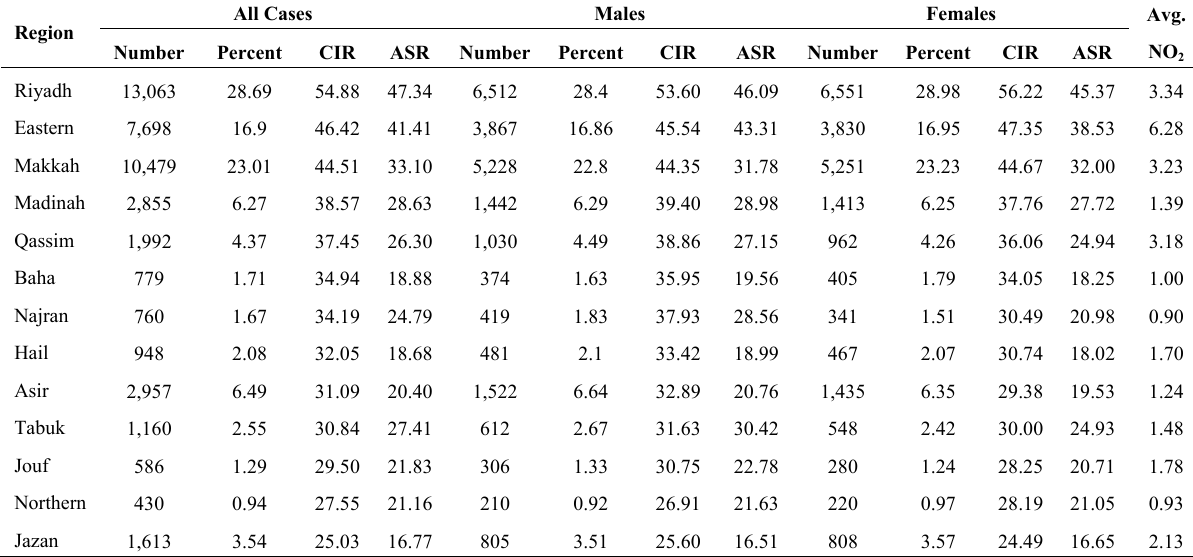
Table 1. Number, percentage, crude incidence rate (CIR) and age-standardized incidence rate (ASR) of all cancers, 1998–2004.